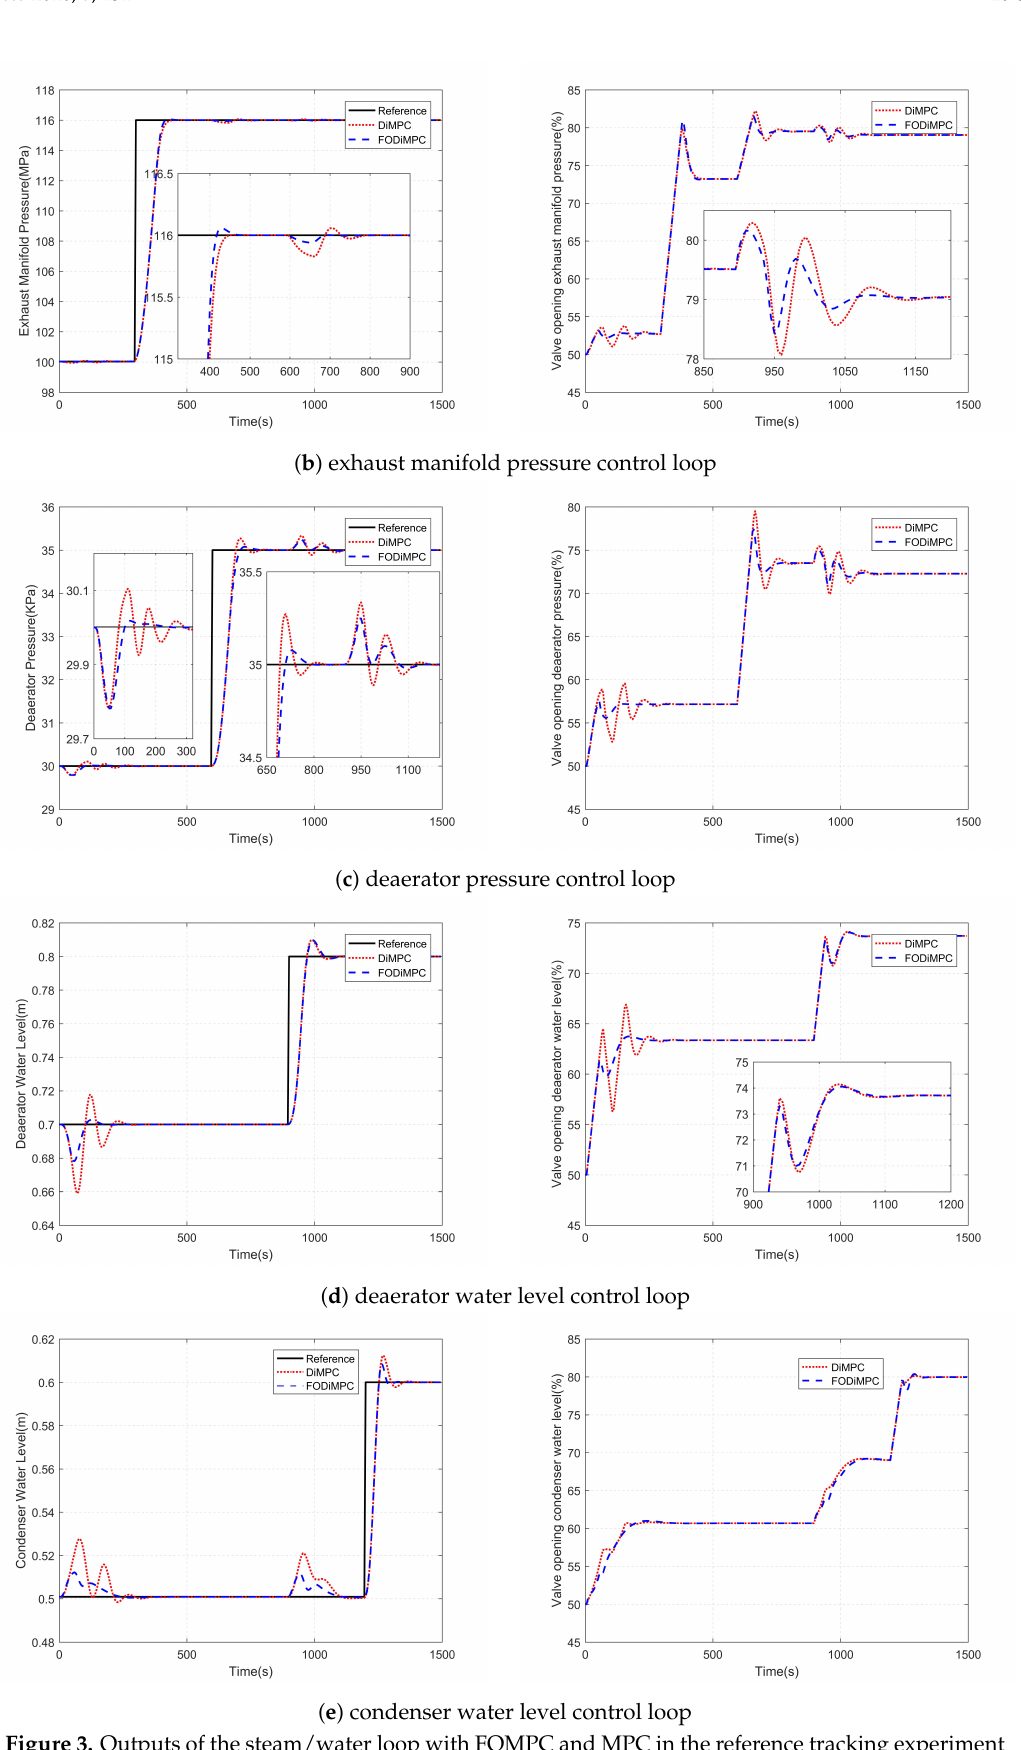
Figure 3. Outputs of the steam/water loop with FOMPC and MPC in the reference tracking experiment (The outputs are listed on the left hand, and the inputs are listed on the right